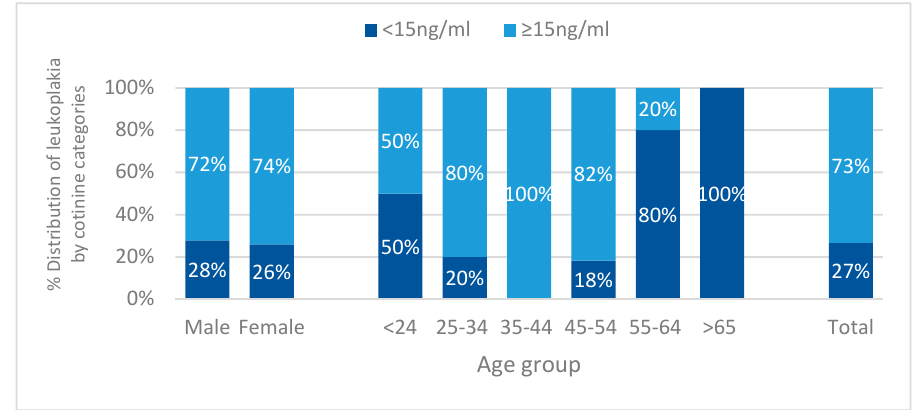
Figure 4. Distribution of leukoplakia according to serum cotinine categories (<15 ng/mL and ≥ 15 ng/mL) in relation to sex ( p = 0.007 for females), age group ( p = 0.01 for 35–44), and total ( p < 0.001).